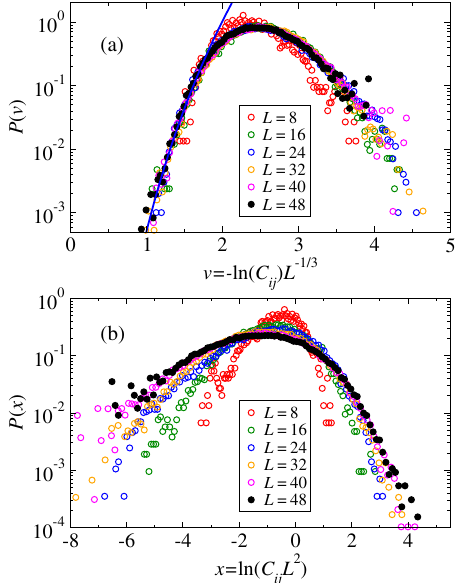
FIG. 13. Two types of histograms showing the distribution of the spin correlations at distance r ¼ ð L= 2 ; L= 2 Þ . In (a), the exponent a in the variable v in Eq. (9) is set to a ¼ 1 = 3 , close to its optimal value for collapse of the data for the larger systems. The blue fitted curve on the left side of the distribution corresponds to the power- law behavior P ð v Þ ∝ v n with n ¼ 11 . In (b), the scaling variable L 2 Þ is x ¼ ln ð C ij